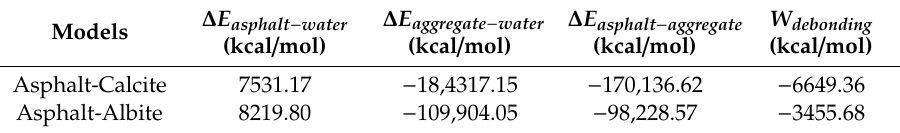
Table 1. Interface interaction and debonding energy for di ff erent